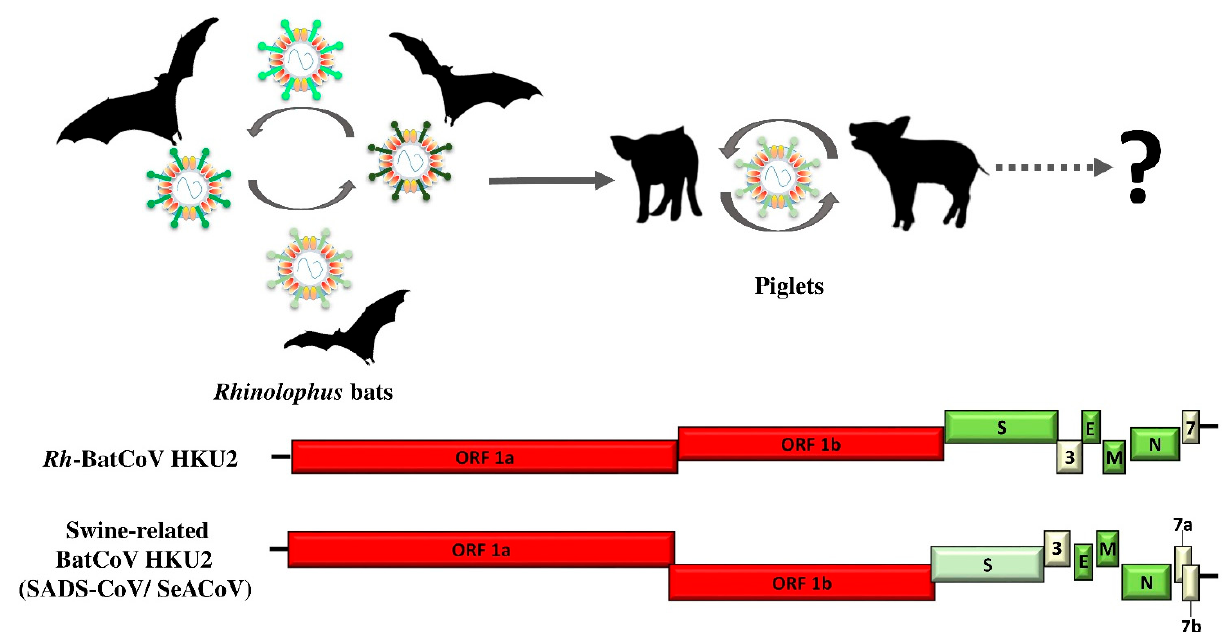
Figure 5. Overview of interspecies transmission events of swine-related BatCoV HKU2 (SADS) outbreak since 2017. Arrows indicate the direction of viral interspecies jumping between different host species. Circular arrows indicate the circulation of virus within the population. Dot arrows indicate the viral interspecies jumping event remains to be elucidated.